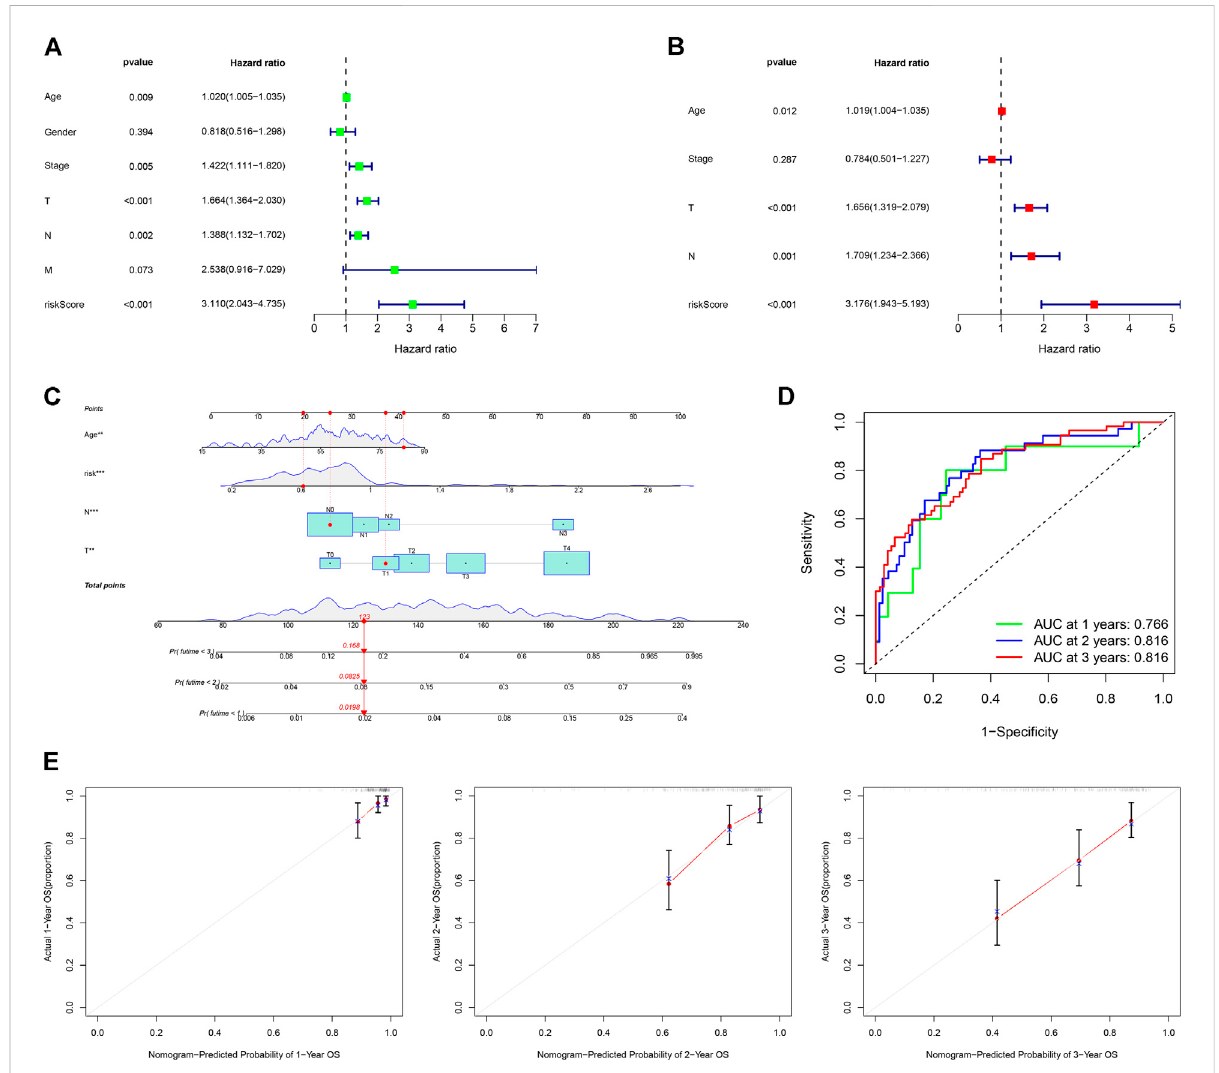
FIGURE 6 Construction and assessment of a nomogram. (A,B) Univariate and multivariate Cox analyses of clinical characteristics to identify independent risk factors for worse OS. (C) A nomogram based on age, T, N stage, and risk scores. (D) ROC curves for 1-, 2- and 3-year OS of CM cases using